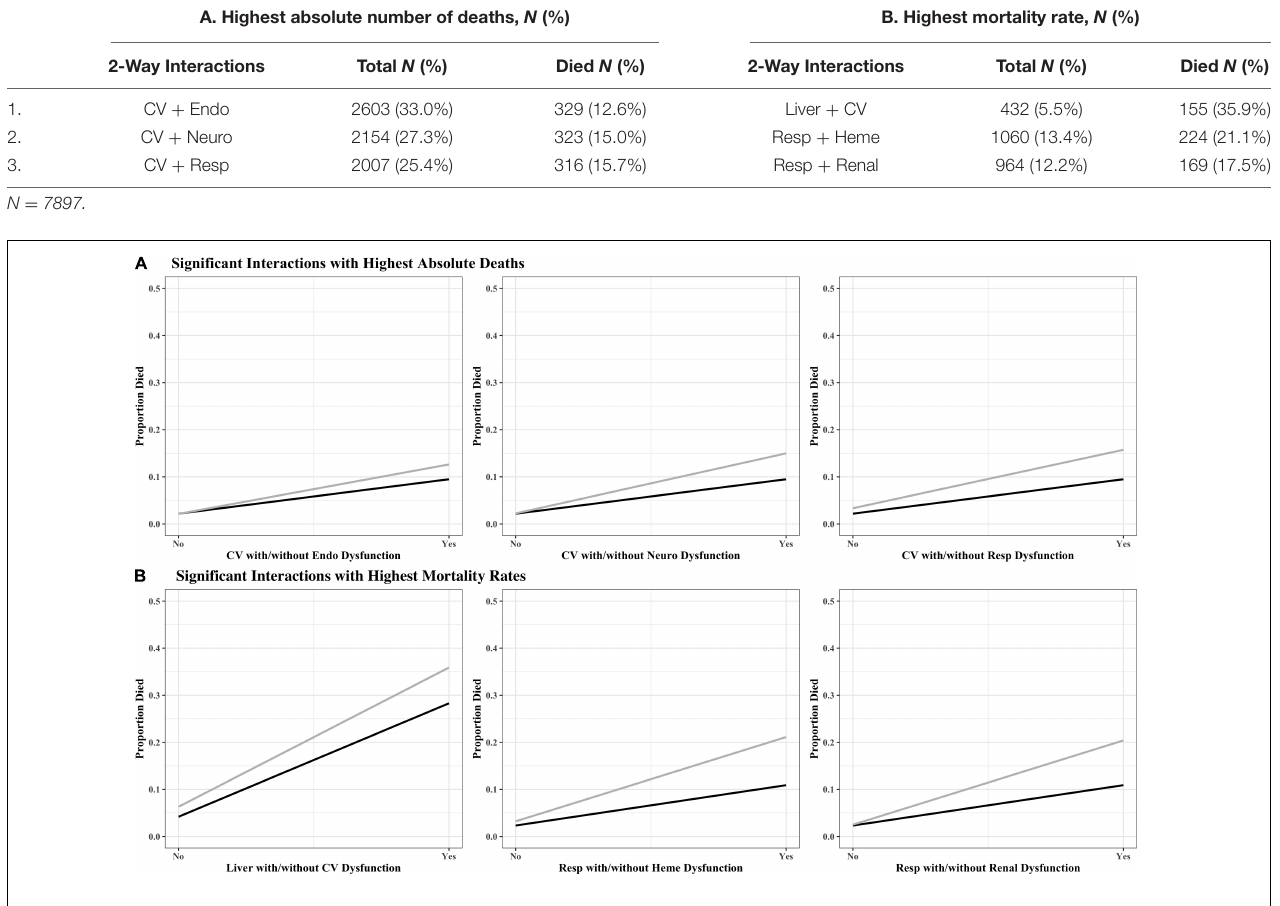
TABLE 2 | Top three organ dysfunction interactions associated with increased mortality, by (A) absolute number of deaths and (B) mortality rate. A. Highest absolute number of deaths, N